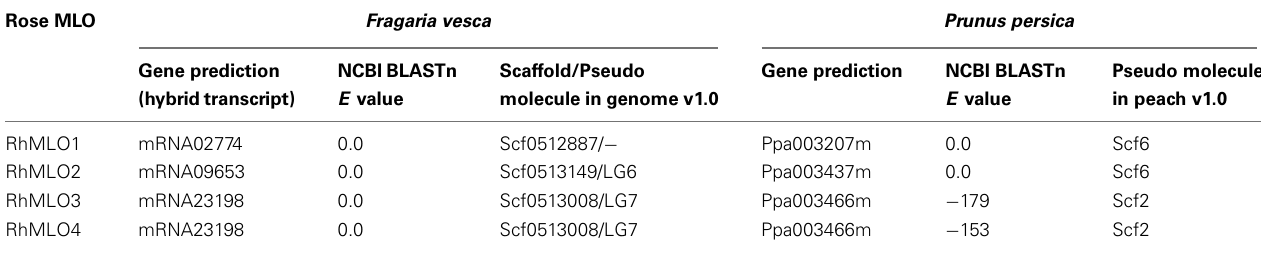
Table 2 | Homologs of RhMLO sequences in the Fragaria vesca and Prunus persica genomes. Rose MLO Fragaria vesca Prunus